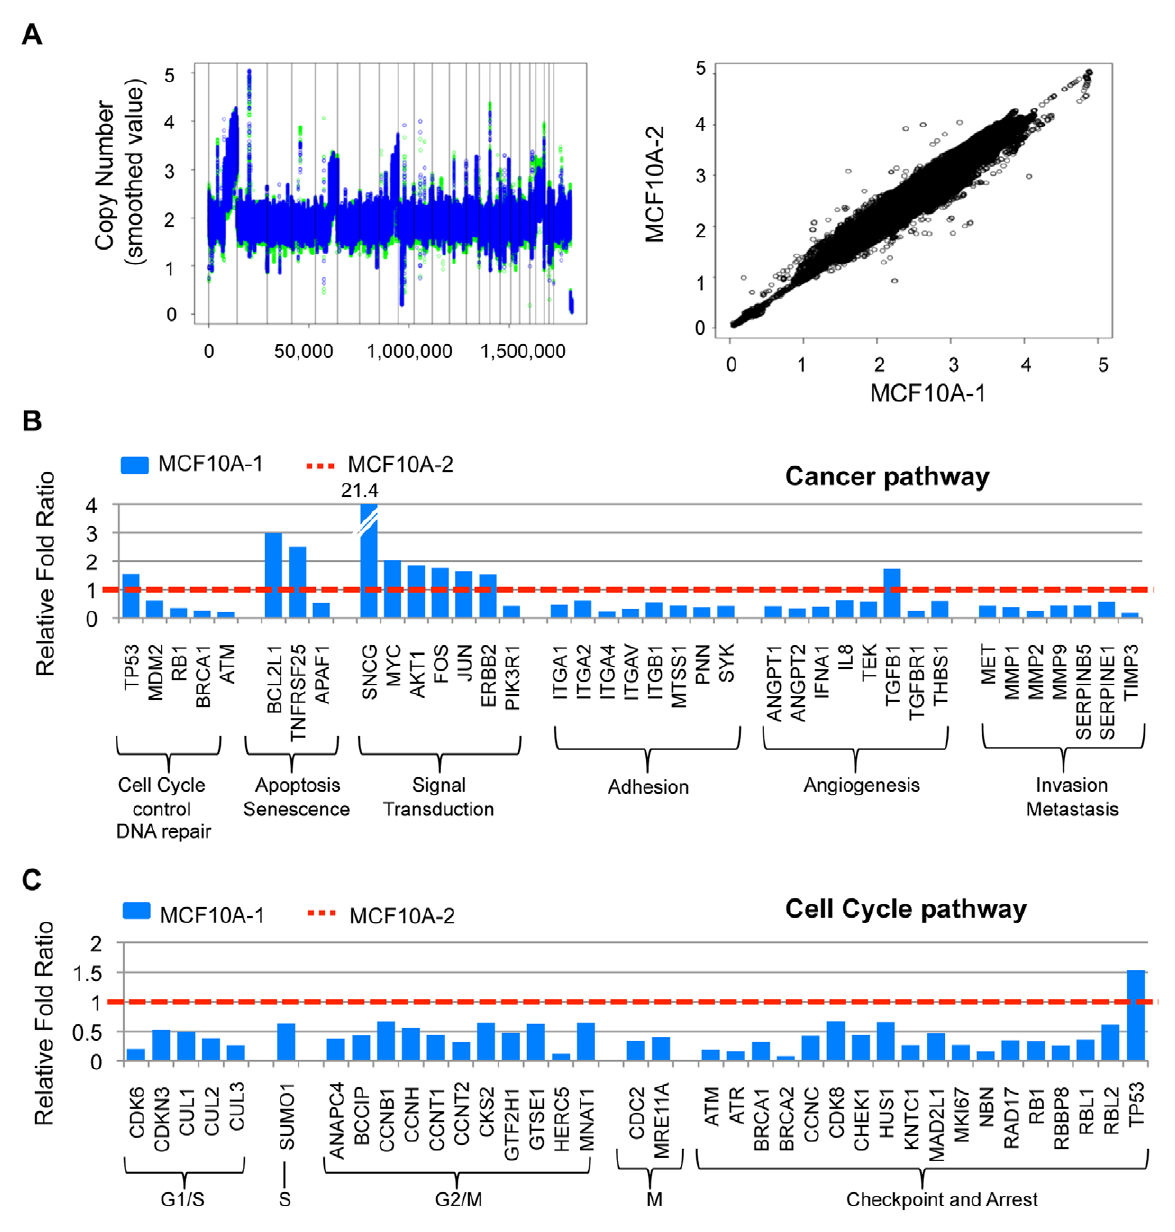
Figure 4. Differential response to SATB1 overexpression by MCF10A-1 and MCF10A-2 cells is attributed to their disparate gene expression patterns involved in cell cycle regulation. A ) (Left) Gene copy number profiles for MCF10A-1 and MCF10A-2. Each dot represents the copy number for a given SNP that is ordered by genomic position, from chromosome 1 to chromosomes X and Y. Vertical lines represent chromosome boundaries for the autosomes. Data for MCF10A-1 and MCF10A-2 are plotted in green and blue, respectively. The copy number profiles for both cell lines were largely overlapping, indicating that the cell lines are genomically the same. (Right) Copy number correlation between MCF10A-1 and MCF10A-2. Each dot represents copy number for a single SNP, where copy number for the MCF10A-1 cell line is plotted along the x- axis and that for the MCF10A-2 cell line is plotted along the y-axis. The Pearson correlation is 0.96 (p , 2.2e-16), which supports the idea that the two cell lines are identical. B ) Expression analysis of genes associated with cancer progression in MCF10A-1 and MCF10A-2. Genes are categorized based on their specific biochemical functions. Fold gene expression in MCF10A-1 (blue bar) relative to MCF10A-2 (red dotted line at 1 fold) is shown. Each gene expression level was normalized to the level of GAPDH. C ) Expression analysis of genes associated with cell cycle regulation in MCF10A-1 and MCF10A-2. Genes are categorized based on their roles in specific cell cycle phases. The result is shown as in ( B ).